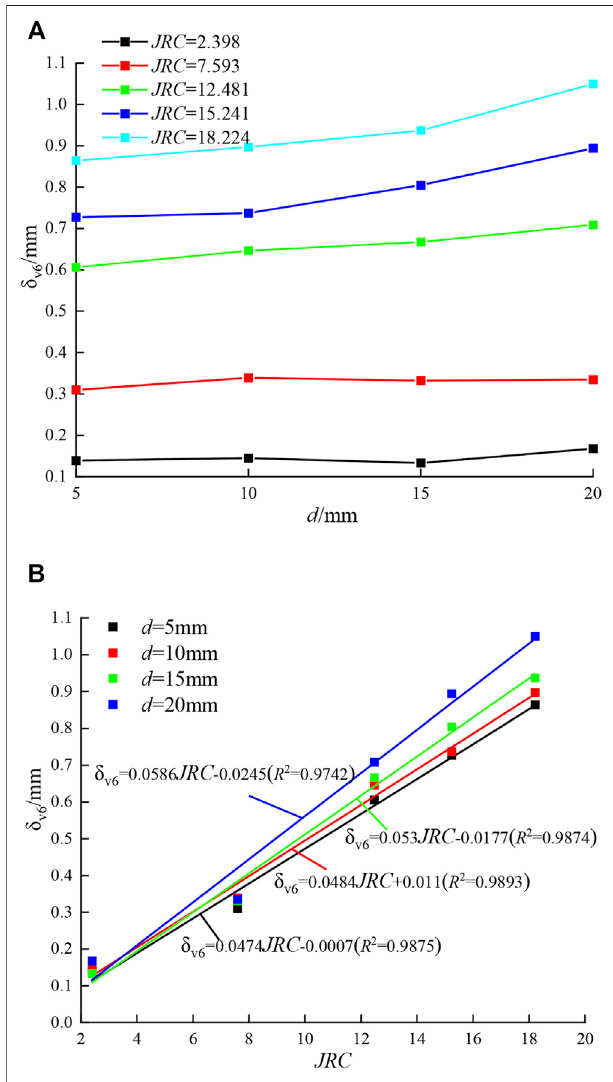
FIGURE 13 | Variation of τ y with d and JRC. (A) d - τ y . (B) JRC- τ y .